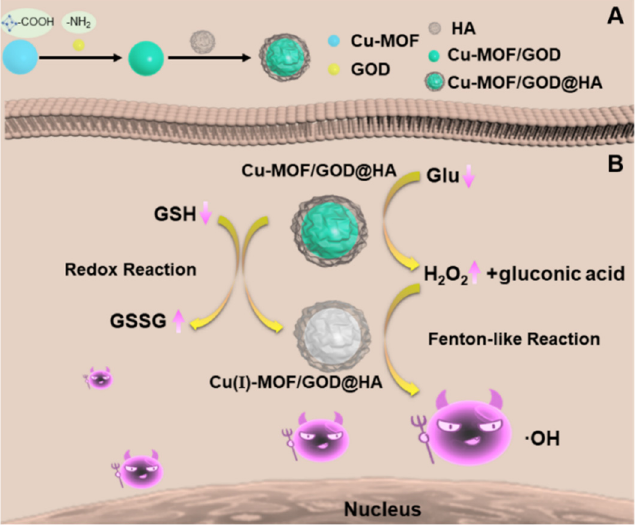
Figure 1. Schematic of the Cu-MOF/GOD@HA preparation process ( A ) and the Cu-containing nanoformulation mediated CDT ( B ).